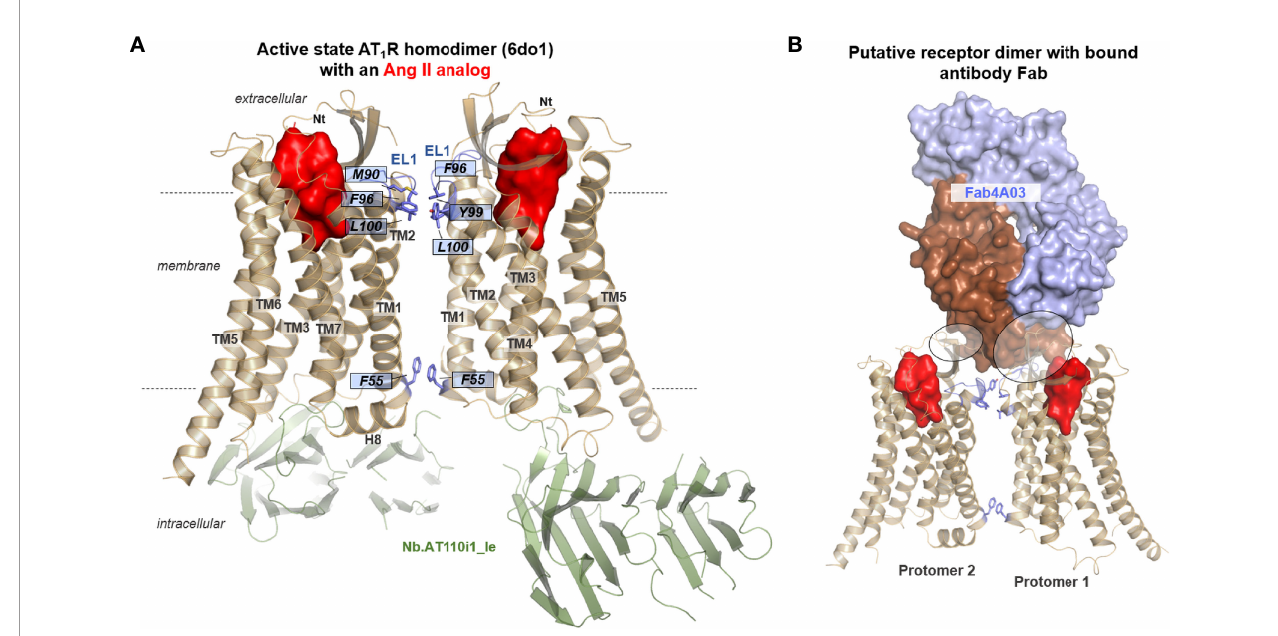
FIGURE 7 | Dimer arrangement of the active state AT 1 R bound with an Ang II analog and nanobodies. (A) The complex between the Ang II analog, AT 1 R, and active state stabilizing nanobodies has been crystallized as a homodimer [PDB ID: 6do1 (62)]. The interface between the protomers is constituted by hydrophobic and aromatic amino acid side chain contacts at EL1 (M90, F96), TM1 (F55, intracellularly), TM2 (Y99), and helix 3 (L100). (B) In a putative scenario of a dimeric receptor arrangement with antibody binding at one protomer, the Fab fragment should also simultaneously contact the second receptor protomer. For this model, the AT 2 R structure (6jod), with and without a Fab, were arranged together as suggested by the AT 1 R